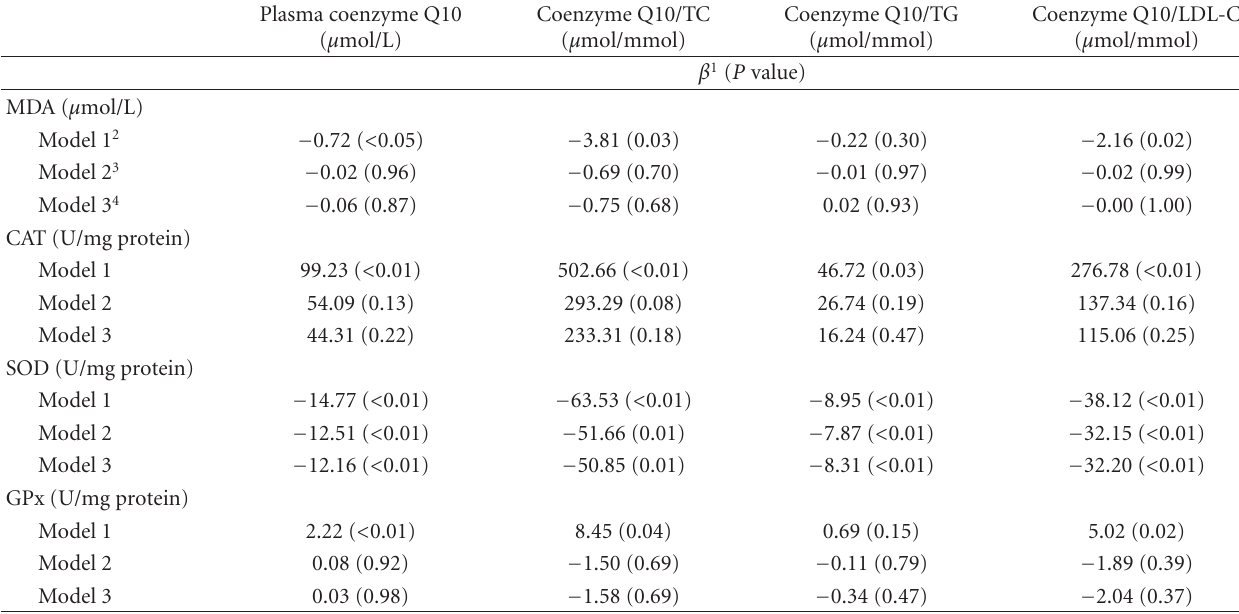
Table 2: Correlations between plasma coenzyme Q10 and the ratios of coenzyme Q10 to lipid profiles, lipid peroxidation, and antioxidant enzyme activities after adjusting for the potential